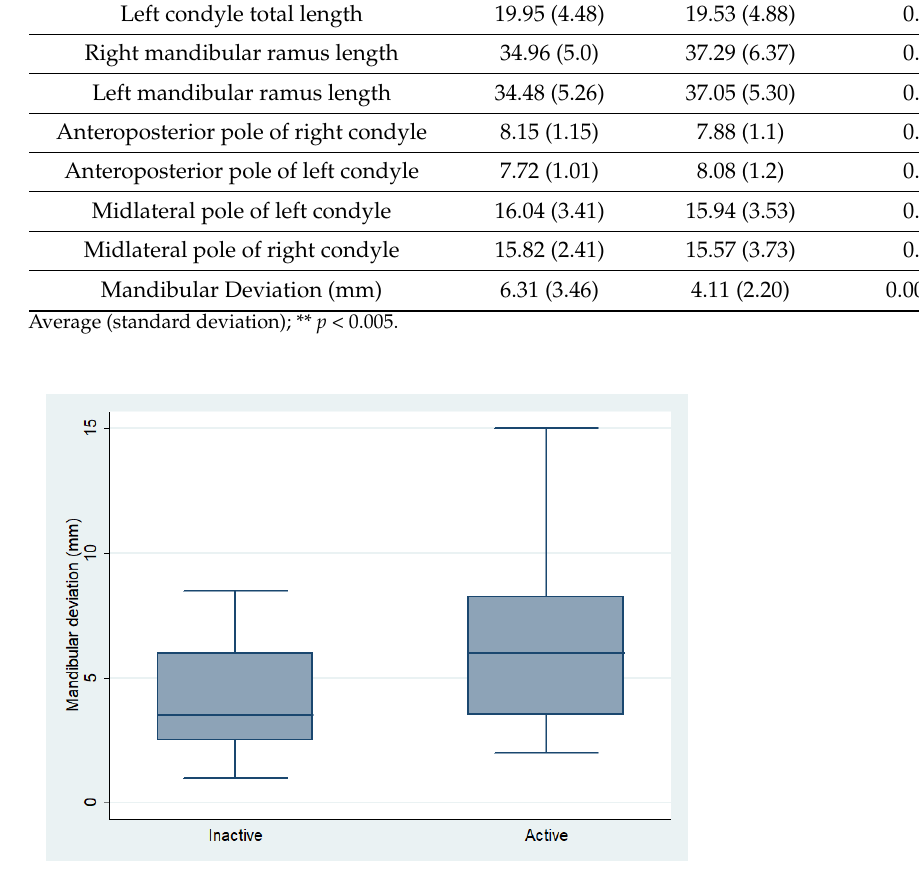
Table 4. Comparison of morphologic measurements in active/inactive unilateral condylar hyper- plasia (UCH) cases.